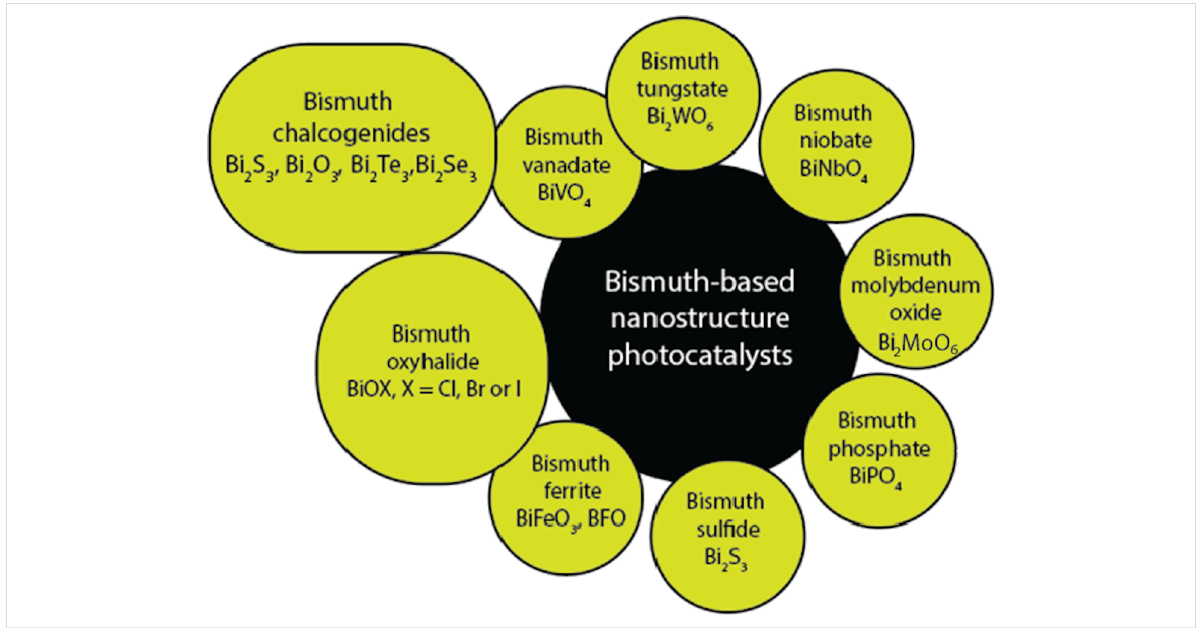
Figure 2: Most recently studied and common bismuth-based nanostructured photocatalysts.